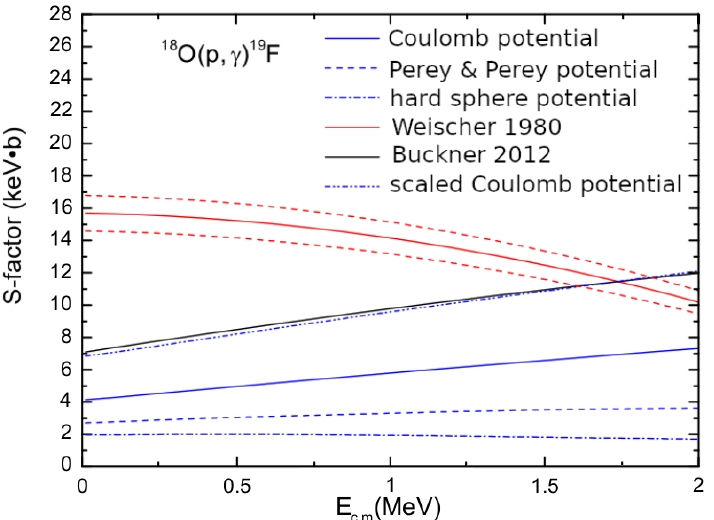
Figure 6. S-factor of the total direct proton capture 18 O(p, γ ) 19 F determined using ANC (picture taken from [56]): The dashed blue line obtained using the Perey and Perey potential [93] shows an opposite trend with respect to [84] (red solid line). The S(E)-factor extracted by [90] (solid black line), along with calculation performed using Coulomb (solid blue line) and hard sphere potentials (dashed-dotted blue lines). A Coulomb potential scaled on data from the results of [90] is also